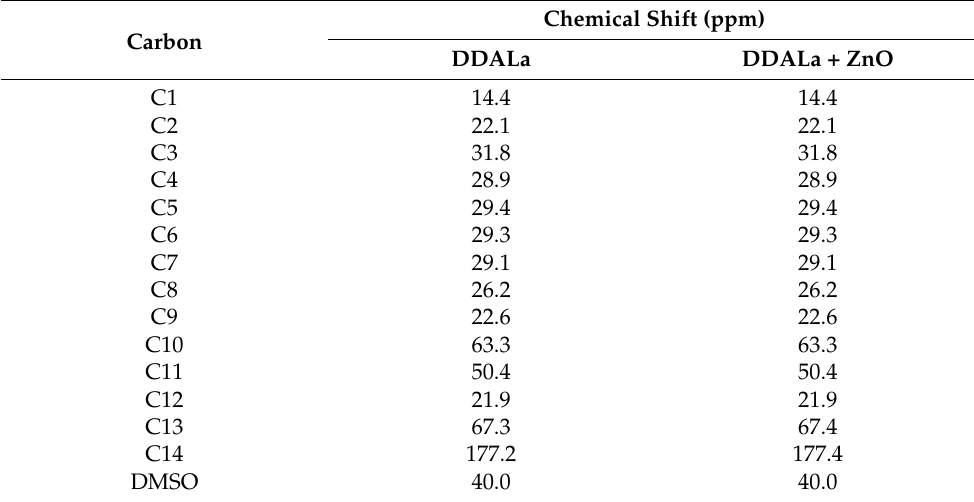
Table 5. 13 C NMR chemical shifts for pure DDALa and its mixture with ZnO (1:2).